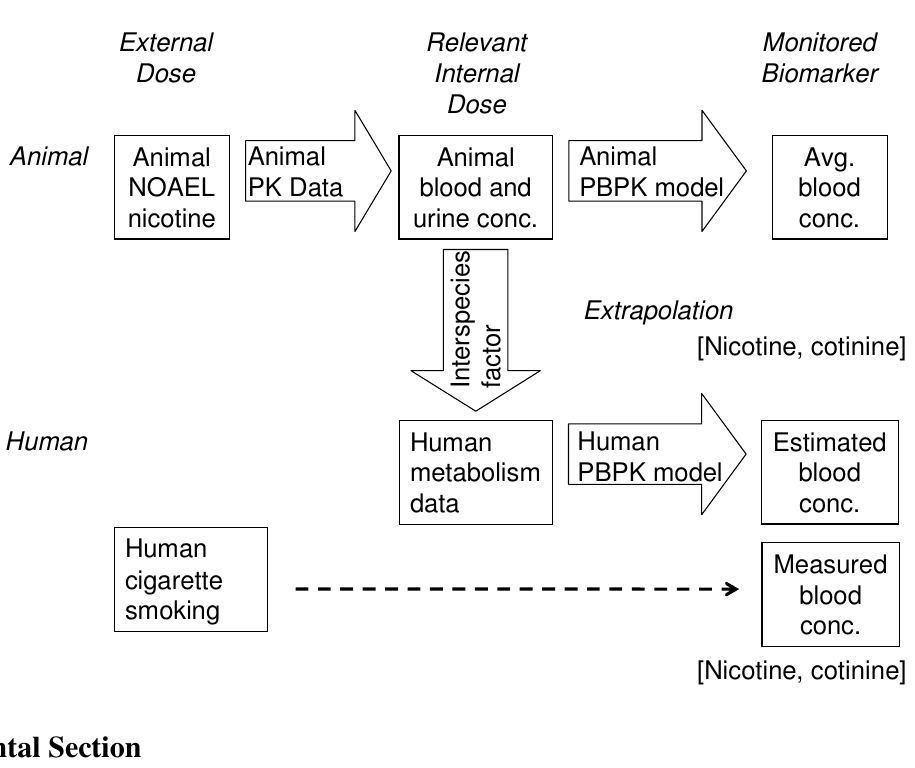
Figure 1. Approach for calculating blood-based biomonitoring equivalents for nicotine. PK, pharmacokinetics. Biomonitoring of nicotine and cotinine in plasma was carried out